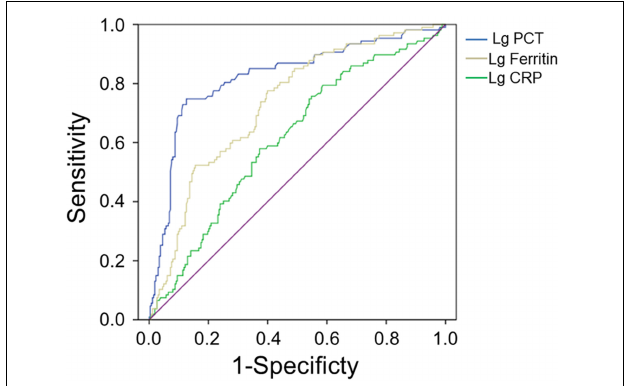
FIGURE 1 | Performance of serum ferritin, PCT, and CRP as predictors of severity by receiver operating characteristics curve analysis. The AUC of serum ferritin = 0.732, the AUC of PCT = 0.824, and the AUC of CRP = 0.614, all p < 0.01.